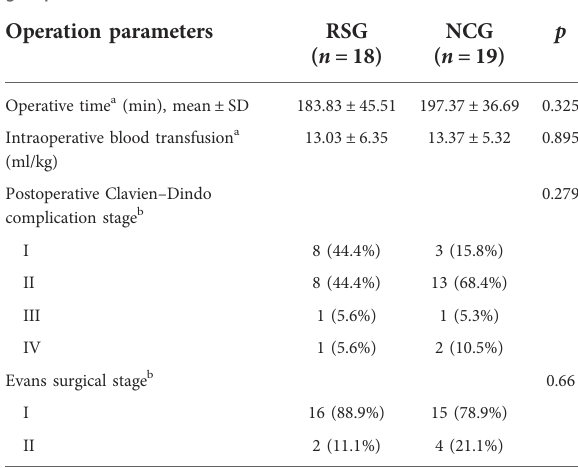
TABLE 4 Comparison of surgery-related parameters between the two